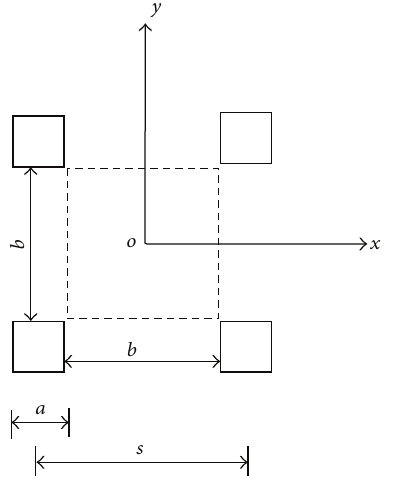
Figure 5: Sketch of 3D model.